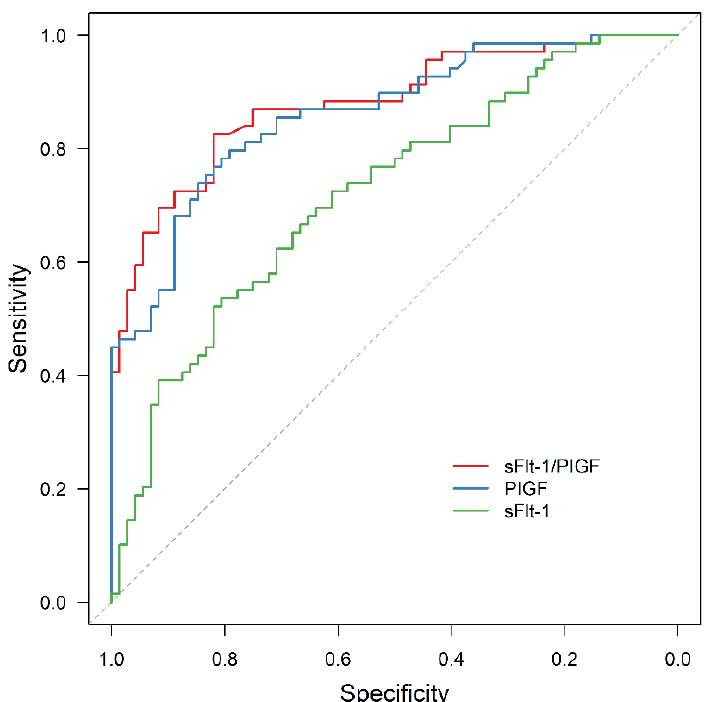
Figure 4. ROC curve for APO prediction by sFlt-1 (AUC = 0.721, 95% CI: 0.637–0.804, p < 0.001), PIGF (AUC = 0.866, 95% CI: 0.807–0.925, p < 0.001) and sFlt-1/PIGF (AUC = 0.880, 95% CI: 0.824–0.936, p < 0.001). ROC receiver operating characteristic, APO adverse perinatal outcome, sFlt-1 soluble fms-like tyrosine kinase-1, PIGF placental growth